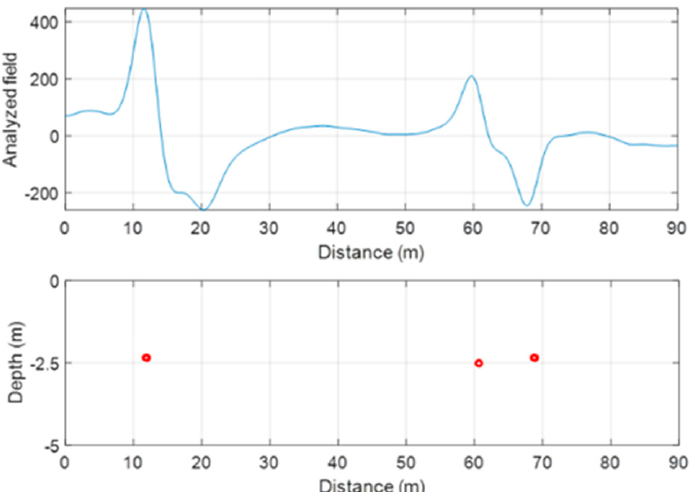
Figure 12. Example of the Euler deconvolution application to profile data. ( a ) Ground survey total field profile at x = 4 m; ( b ) Euler deconvolution solutions (red dots), localized at the position of the center of the sources of the magnetic anomalies.